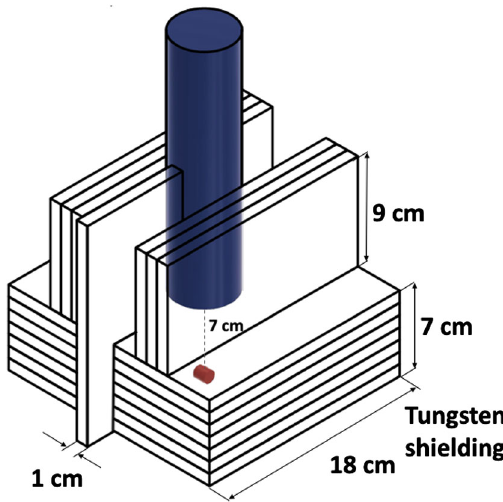
FIG. 8. Experimental setup of HPGe detector used at the University of Illinois Urbana-Champaign. The transparent plates represent the tungsten shielding. The blue cylinder is the HPGe detector and the red cylinder indicates the location of the sample during measurements.